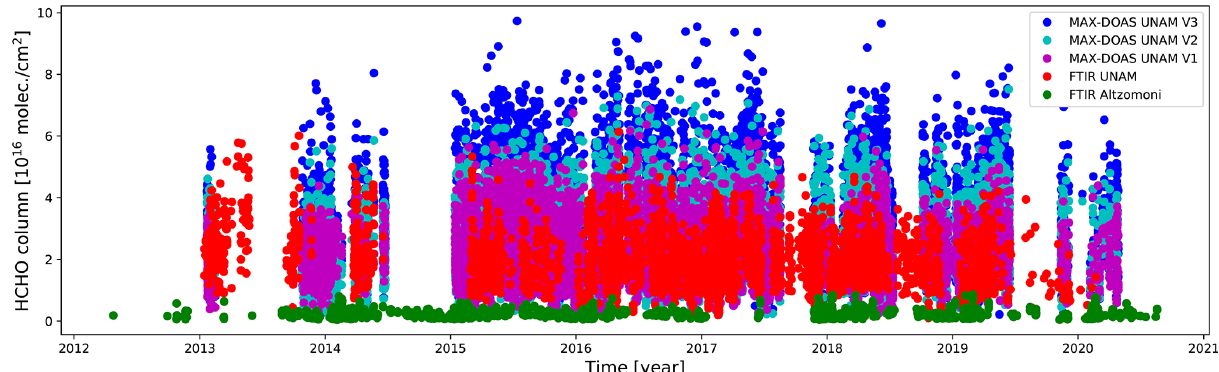
Figure 1. Hourly means of HCHO vertical column densities (VCDs) from the MAX-DOAS instrument at UNAM (V1, magenta; V2, cyan; and V3, blue) and the solar-absorption FTIR instrument at UNAM (red) and at Altzomoni (green). The measurements in Mexico City at the UNAM campus (red, magenta, cyan and blue) are 1 order of magnitude higher than the background measurements at the mountain site of Altzomoni (green). The same applies to their variance. The difference between the MAX-DOAS and FTIR measurements at UNAM is mainly explained by their averaging kernel and is discussed in detail in the text. The altitude ranges covered by each instrument are as follows: for the FTIR instrument at UNAM, VCDs of 2–16km; for the FTIR instrument at Altzomoni, VCDs of 4–16km; and for the MAX-DOAS instrument at UNAM, VCDs of 2–5km.